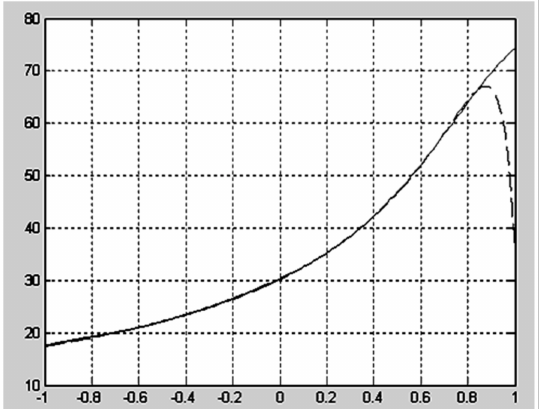
Figure 7. Dependences of the operating device profiles taking into account the width of its side face according to condition (35). (dashed)—describes the dependence of the profile change when its strength is equal; (solid line)—describes the relationship that determines the optimal profile of the operating